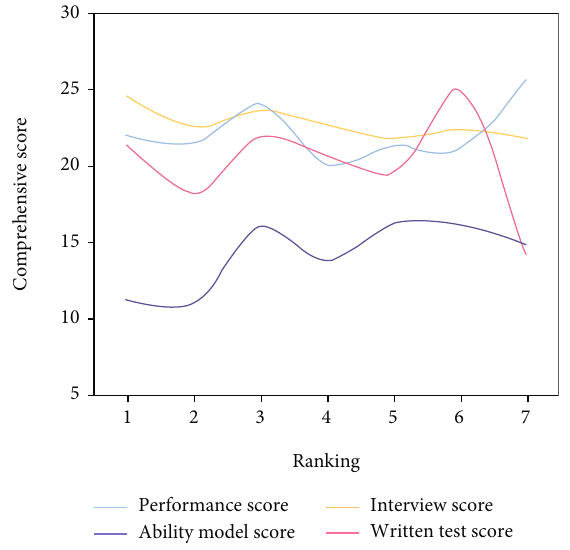
Figure 6: Comprehensive score of internal employment. Table 1: Comparative experimental